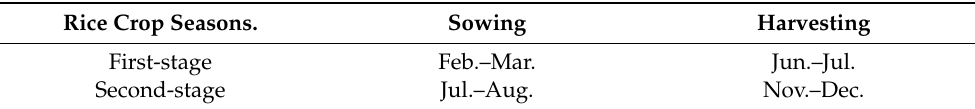
Table 1. Sowing and harvesting time of different rice crop seasons in Taiwan. Rice Crop Seasons.